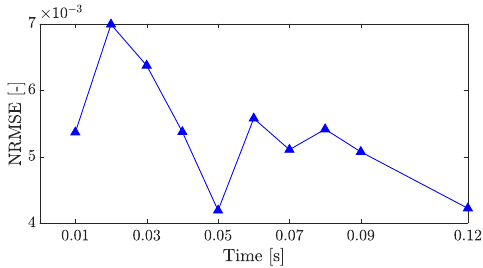
Figure 5. Averaged normalized root mean square error over time of the unsteady adaptive simulation obtained with a sinusoidal perturbation in the velocity profile ( f = 10 Hz, A = 0.25) with reduced mechanisms ( (cid:101) DRGEP = 0.005) obtained from the SKM partitioning, auto scaling